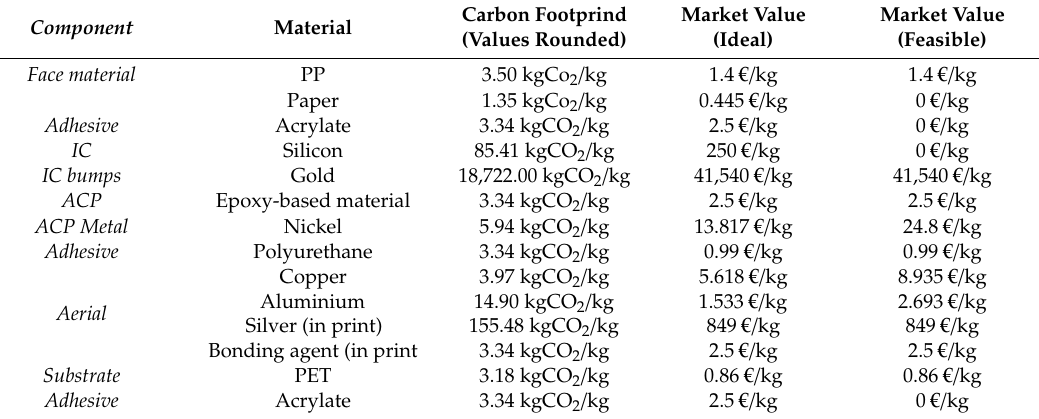
Table 7. The theoretical environmental and economic impact of RFID tag recovered